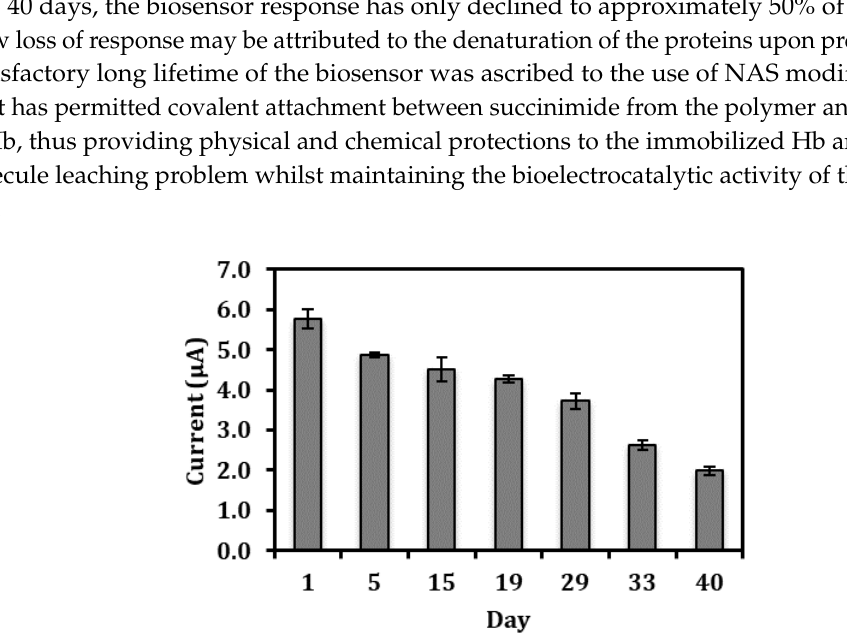
Figure 6. The shelf life profile of the electrochemical nitrite biosensor over a period of 40 days.